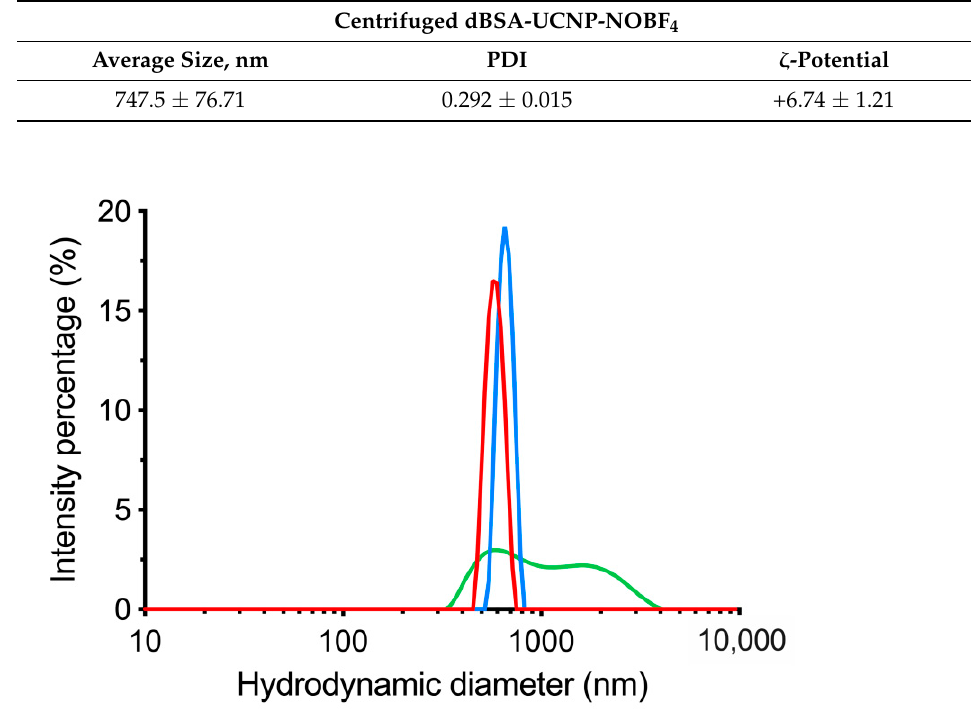
Figure 4. Hydrodynamic diameter of dBSA-UCNP-NOBF 4 after using centrifugation. dBSA-UCNP-NOBF 4 were measured by DLS following the incubation of UCNP-NOBF 4 (0.25 mg/mL) with dBSA (concentration over 50 µ M) and centrifuged at 10,000 × g for 7 min. DLS three repeated size measurements are shown in blue, red, and green.